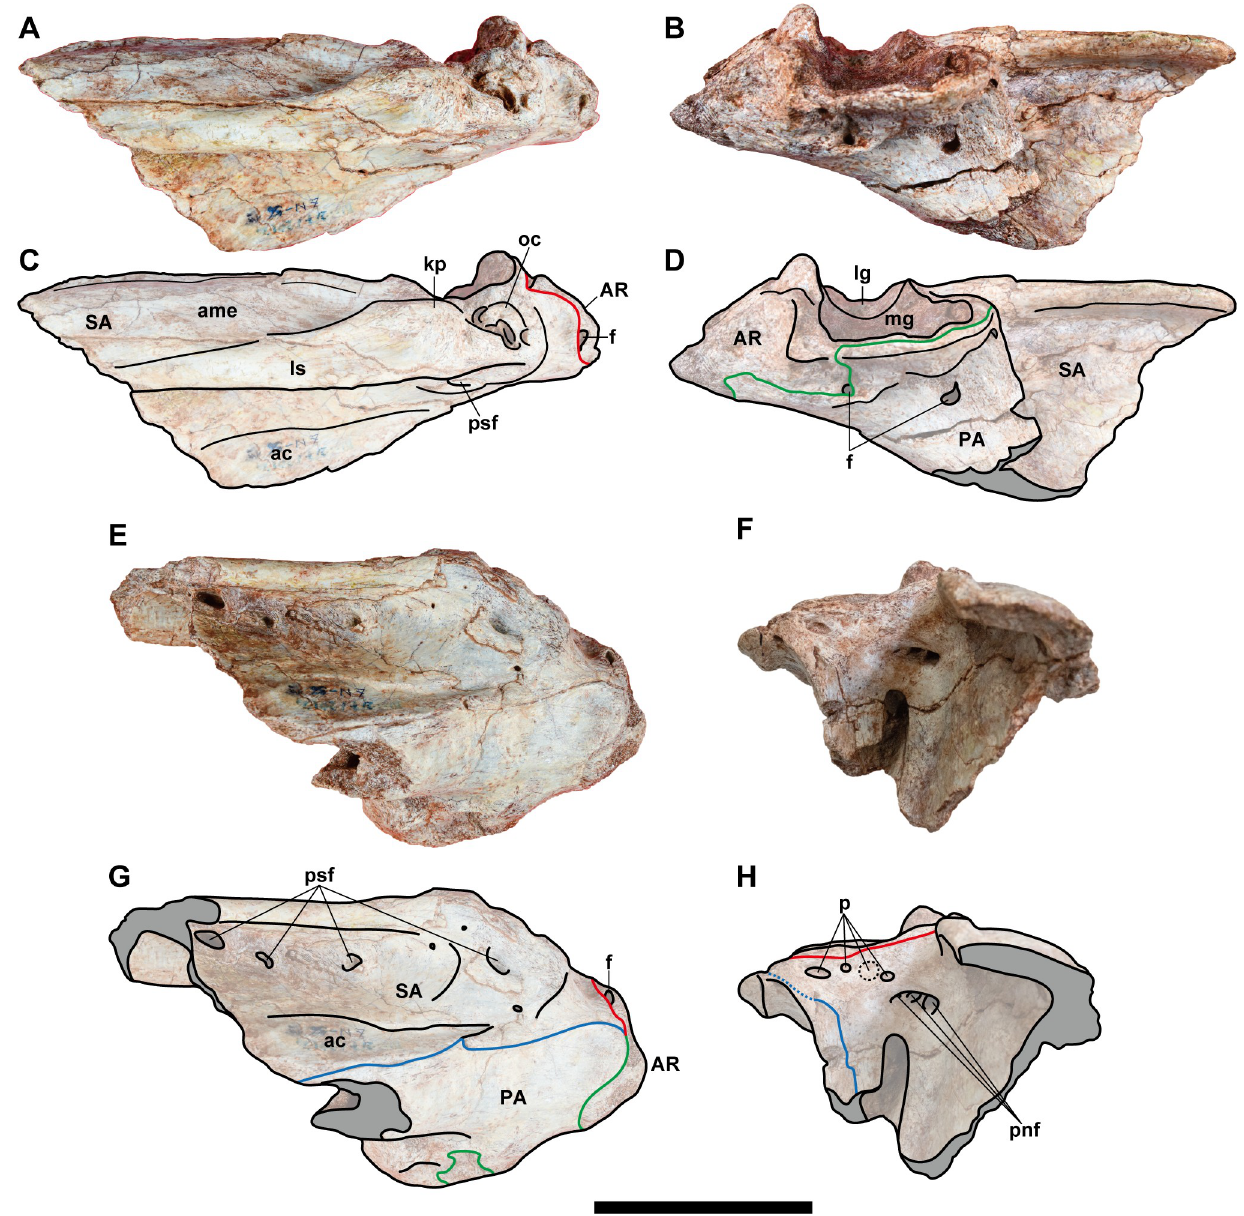
Fig 7. Posterior part of the left mandible (NRRU-F01020009) in lateral (A, C), medial (B, D), ventral (E, G), and anterior (F, H) views. Red, blue, and green lines indicate the surangular (SA)/articular (AR), surangular/prearticular (PA), and articular/prearticular sutures, respectively. Abbreviations: ac, angular contact; ame, M . adductor mandibulae externus attachment; ampsf; anteromedial ends of posterior surangular foramina; f, foramen; kp, knob- like process; lg, lateral glenoid; ls, lateral shelf; mg, medial glenoid; oc, oval concavity; p, pits; pnf, pneumatic foramen; psf, posterior surangular foramen. Scale bar equals 100